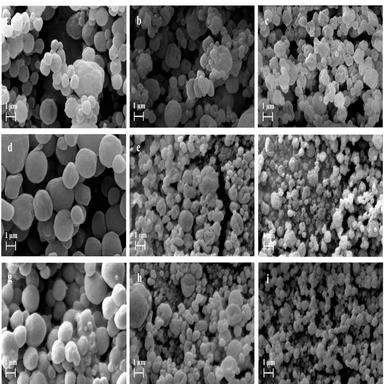
SEM microphotographs of in situ gelling powders. Blank particles made by alginate-pectin-chitosan at different ratios: (a) APC 111, (b) APC 113, (c) APC 117; second line particles with high molecular weight hyaluronate (d) APCH 111–0.5HH, (e) APCH 113–0.5HH, (f) APCH 117–0.5HH; third line particles with low molecular weight hyaluronate: (g) APCH 111–0.5LH, (h) APCH 113–0.5LH, (i) APCH 117–0.5LH.